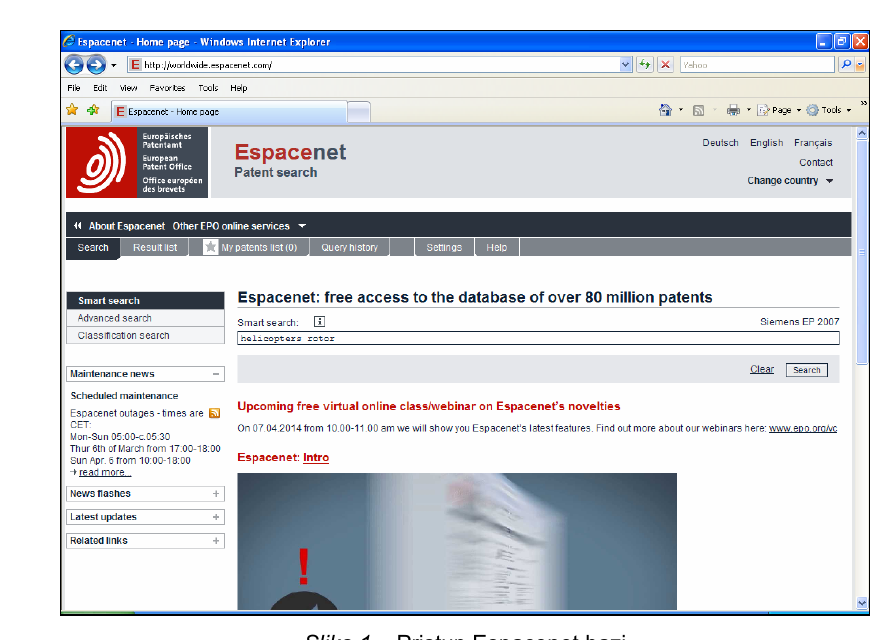
Figure 1 – Access to the Espacenet base Рис . 1 – Доступ к базе данных